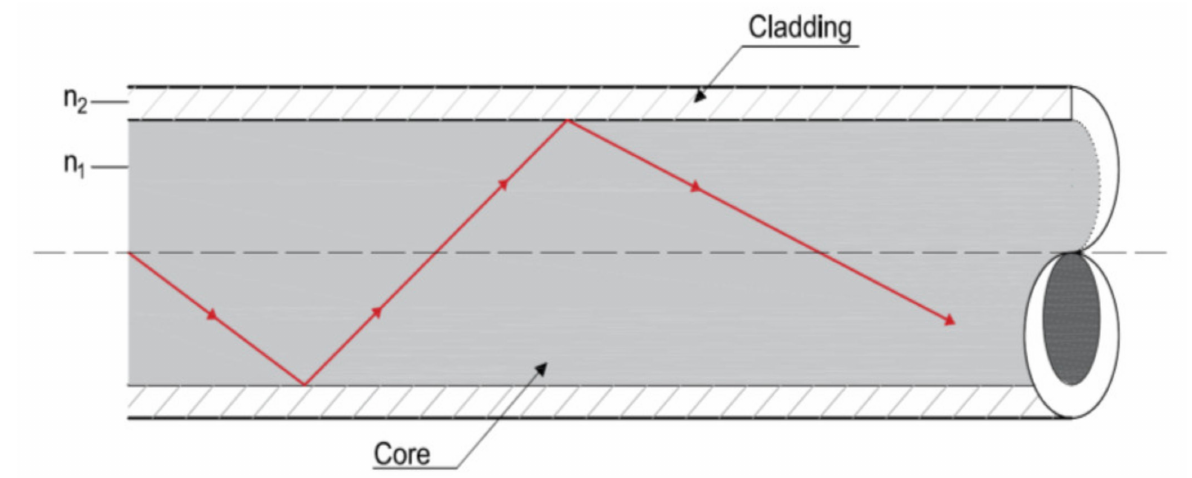
Figure 5. An optical fiber along with light guiding and reflection